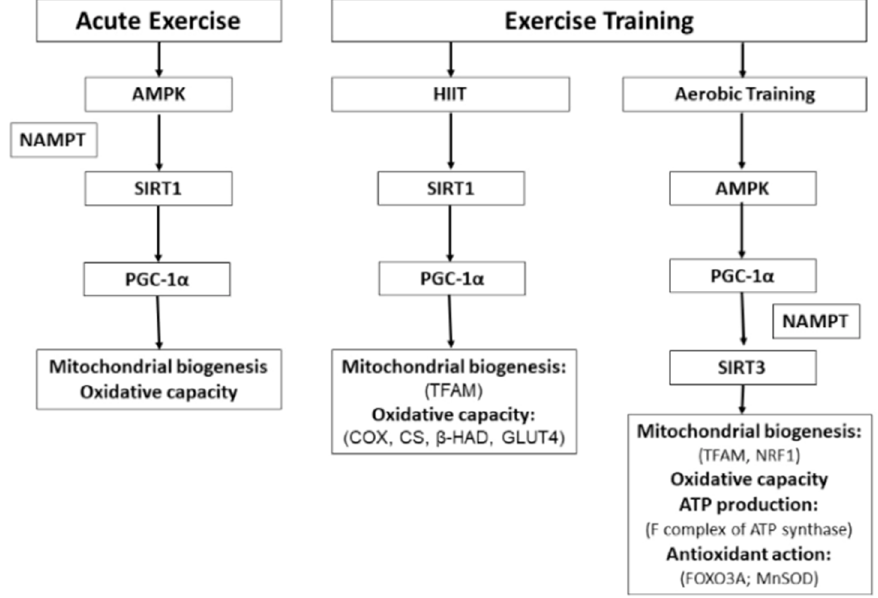
Figure 1. Main observed effects of different types of exercise on SIRT1 and SIRT3 in human skeletal muscle and the metabolic pathways involved. The molecules for which there is direct evidence derived from exercise interventions in humans appear in parentheses. AMPK, AMP-activated protein kinase; β -HAD, β -hydroxyacyl-CoA dehydrogenase; COX, cytochrome C oxidase; CS, citrate synthase; FOXO3A, forkhead box O3; GLUT4, glucose transporter 4; HIIT, high-intensity interval training; MnSOD, manganese superoxide dismutase; NAMPT, nicotinamide phosphoribosyltransferase; NRF1, nuclear respiratory factor 1; PGC-1 α , peroxisome proliferator-activated receptor gamma coactivator-1 α ; TFAM, mitochondrial transcription factor A. The arrows indicate activation or increase.